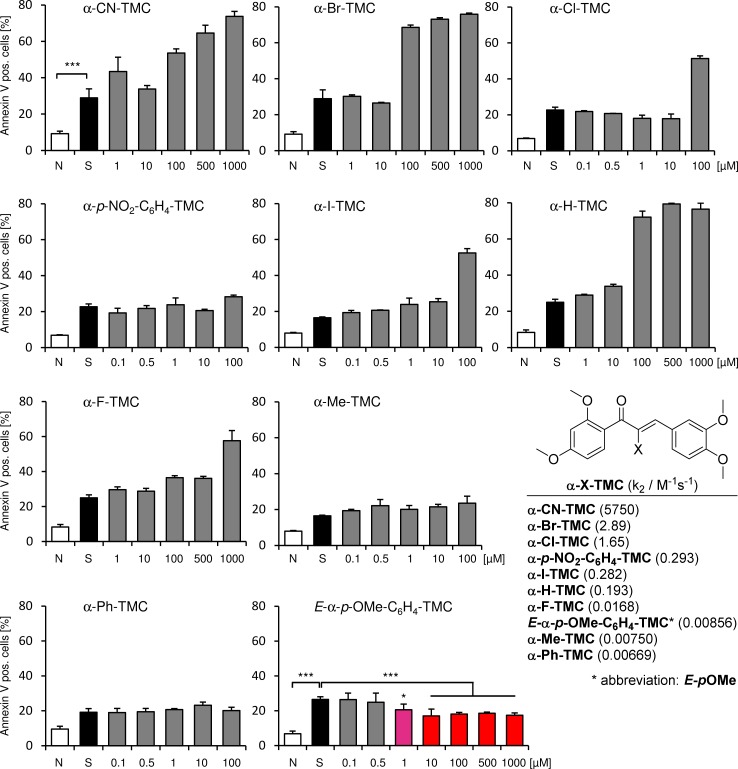
Flow cytometric analysis.Effect of different chalcones on staurosporine-induced apoptosis in RAW264.7 macrophages. Cells were pretreated with the indicated concentrations of chalcones for 3 h, before apoptosis was induced by staurosporine (1 μM for 2 h). Cells were harvested and stained with FITC annexin-V and propidium iodide. 1 × 104 cells were analyzed in each experiment. (n = 4; mean ± S.E.M.; *** = p < 0.001 untreated vs. staurosporine and staurosporine vs. 10, 100, 500 and 1000 μM E-α-p-OMe-C6H4-TMC + staurosporine and * = p < 0.05 staurosporine vs. 1 μM E-α-p-OMe-C6H4-TMC + staurosporine). k2 values for the reaction with the model thiol cysteamine are taken from [21]. N, native; S, staurosporine.